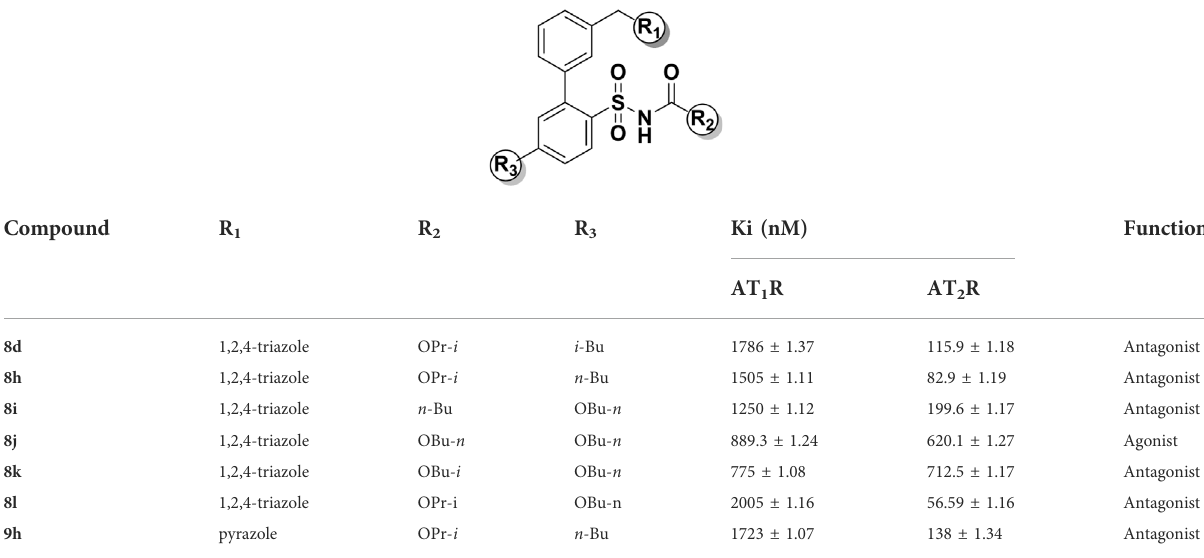
TABLE 2 Differences in structure, af fi nity, and functional activity of compounds.